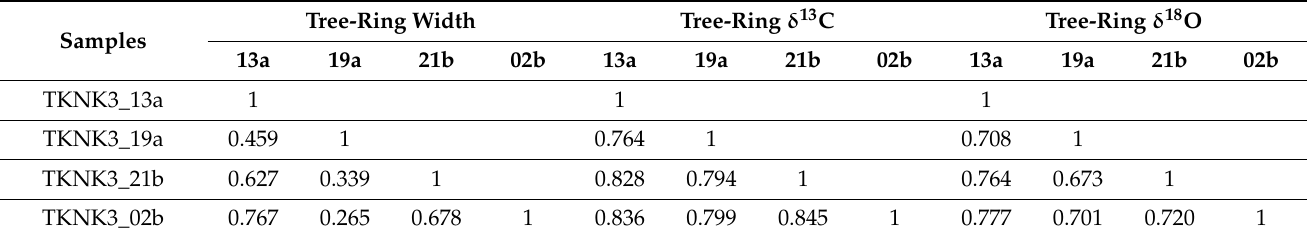
All statistics are significant at the p < 0.01